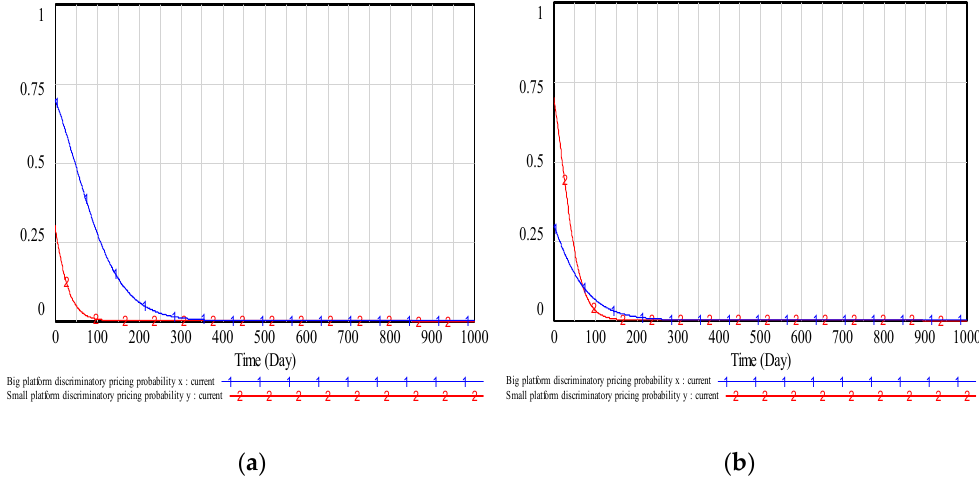
Figure 2. The dynamic evolution paths of case ① . ( a ) The initial proportion pair of both types of platforms is (0.7,0.3) . ( b ) The initial proportion pair of both types of platforms is (0.3,0.7) .